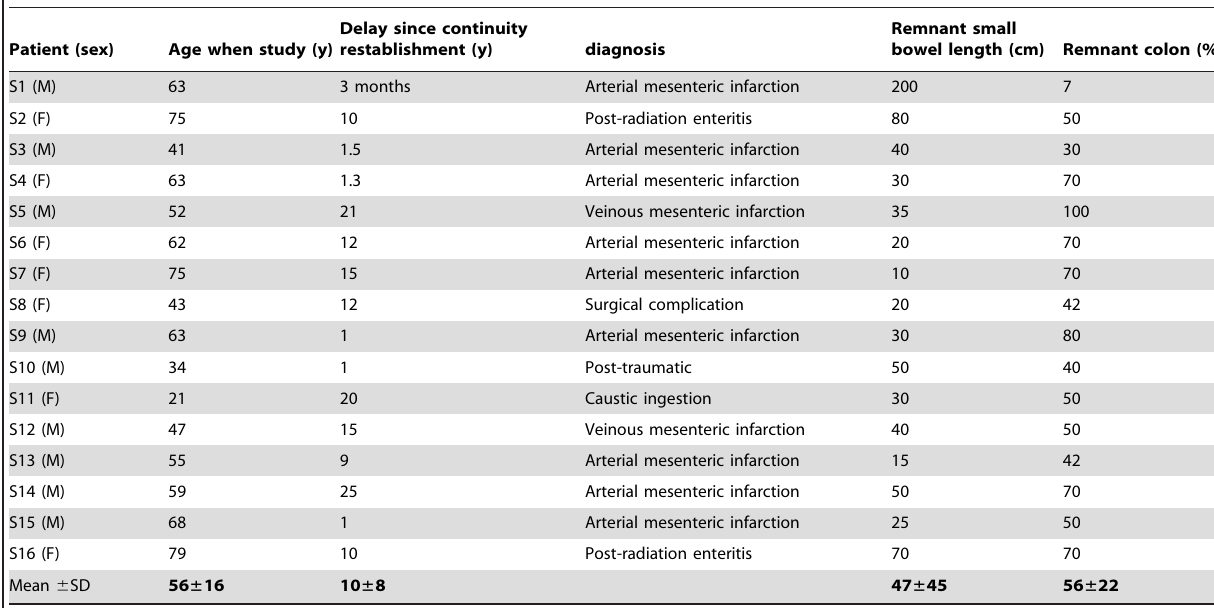
Table 2. Clinical characteristics of SBS